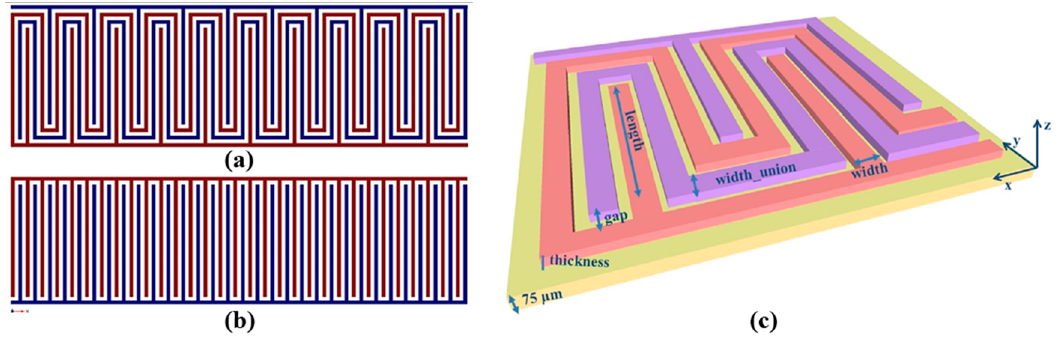
Figure 10. Serpentine ( a ) and IDE ( b ) geometries designed in the same area; design parameters for the novel proposed capacitor onto Kapton substrate ( c ) (reproduced with permission from [35] copyright 2014, Elsevier).